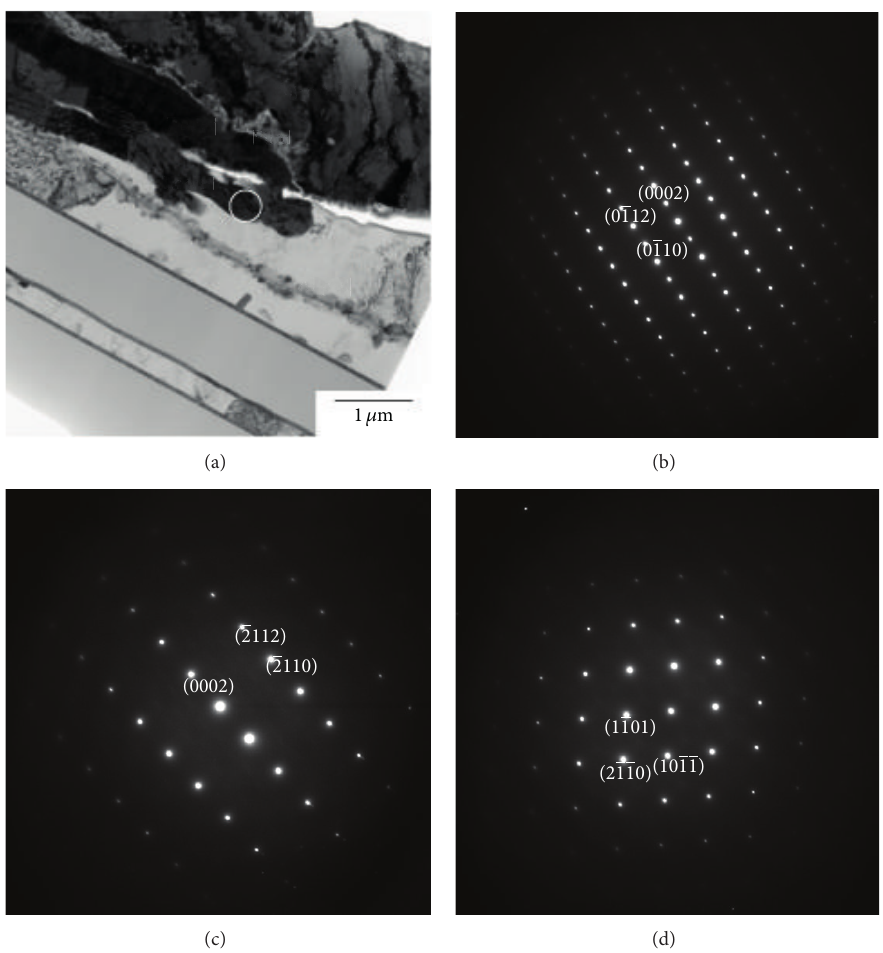
Figure 5: IMCs below the bonding interface were found to be Ag 2 Al (hexagonal